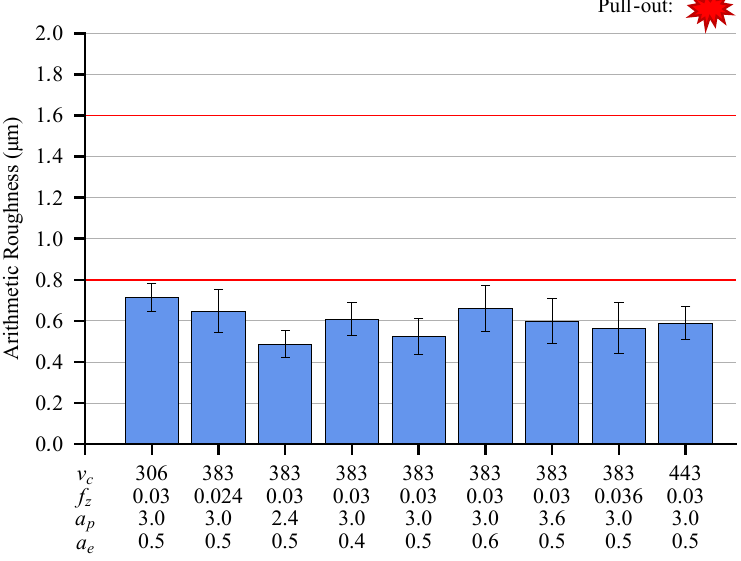
Figure 6. Qualification test of the thermoplastic tool, the evolution of Ra (µm) for different v c (m/min), f z (mm/tooth), a p (mm), and a e (mm). No material pull-out was observed.